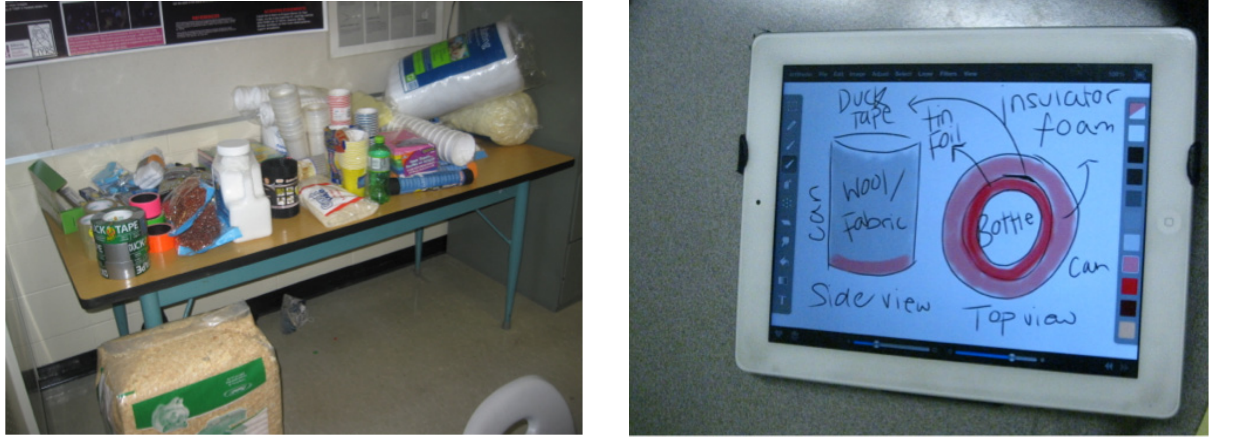
Figure 4. Materials provided for the construction of the thermos in the second session of the project.